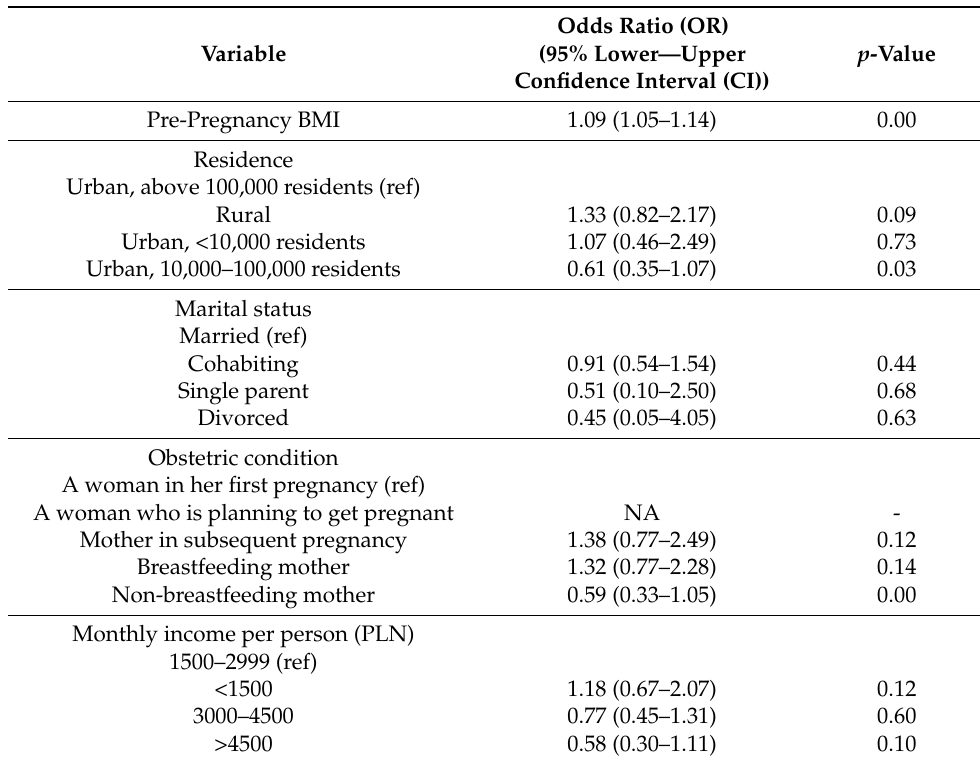
Table 8. Predictors of good knowledge of